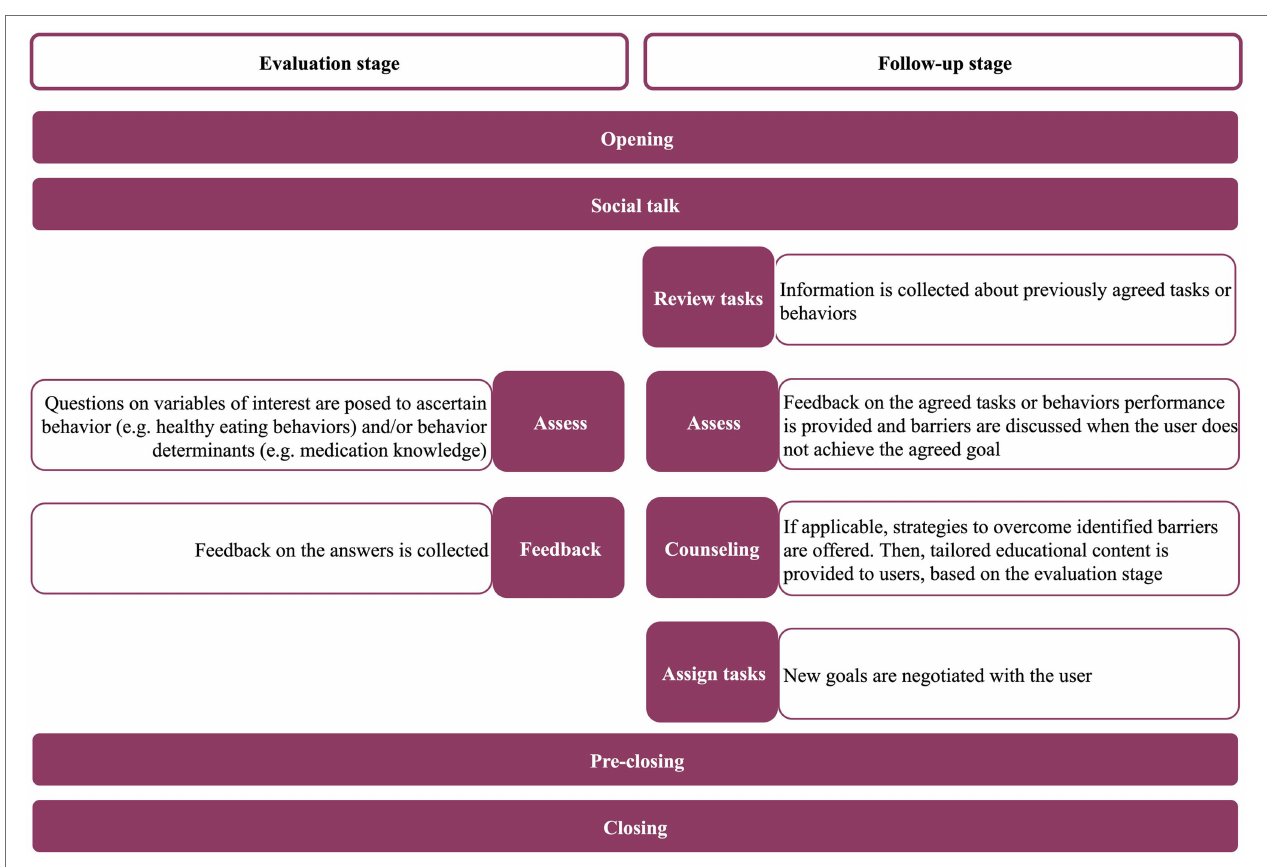
FIGURE 1 | Steps of each daily interaction in the evaluation and follow-up stages across the three components (medication taking, physical activity and healthy